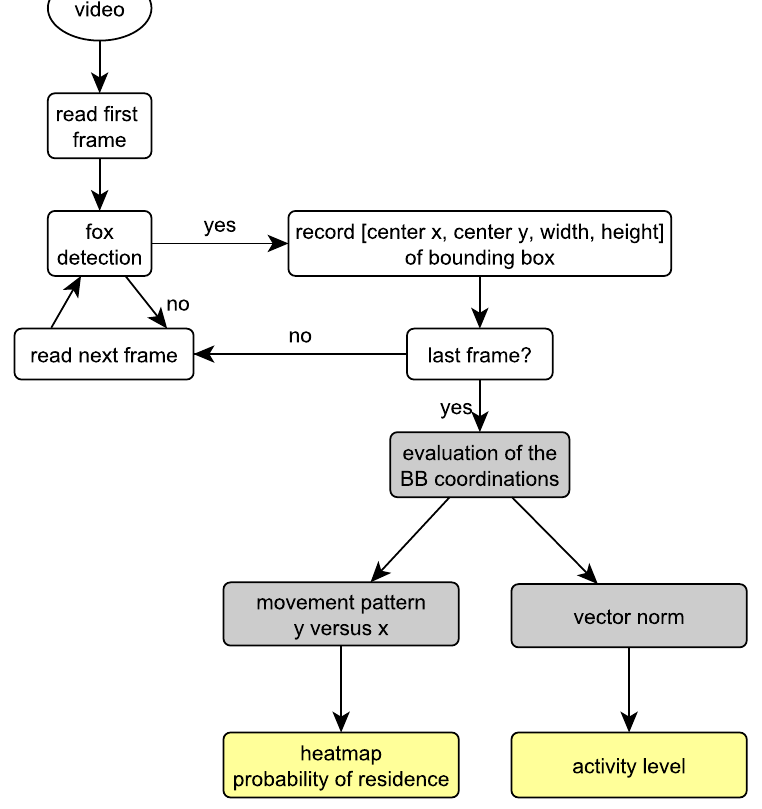
Figure 2. Fox detection and generation of movement patterns. White: evaluation of video data. Grey: evaluation of bounding box (BB) coordination. Yellow: